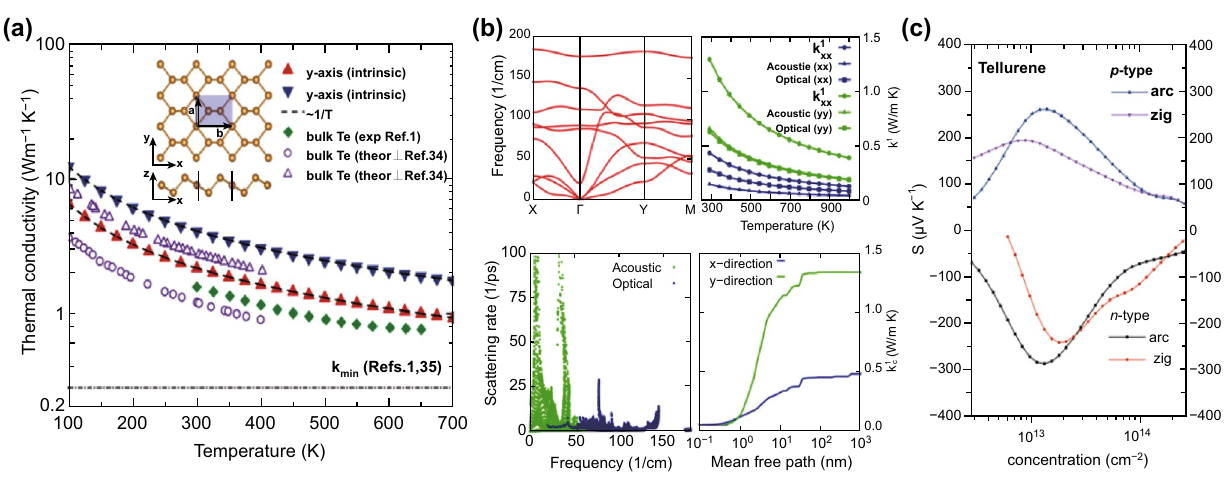
Fig. 9 a Temperature dependence of the 2D Te lattice thermal conductivity. Adapted with permission from [94]. Copyright 2018, The Royal Society of Chemistry. b Phonon band structure, lattice thermal conductivity, scattering rate, and cumulative lattice thermal conductivity, top‑left to bottom‑right, respectively. Adapted with permission from [95]. Copyright 2018, American Chemical Society. c Seebeck coefficient (S) along the armchair and zigzag directions at 300 K. Adapted with permission from [29]. Copyright 2018, The Royal Society of Chemistry